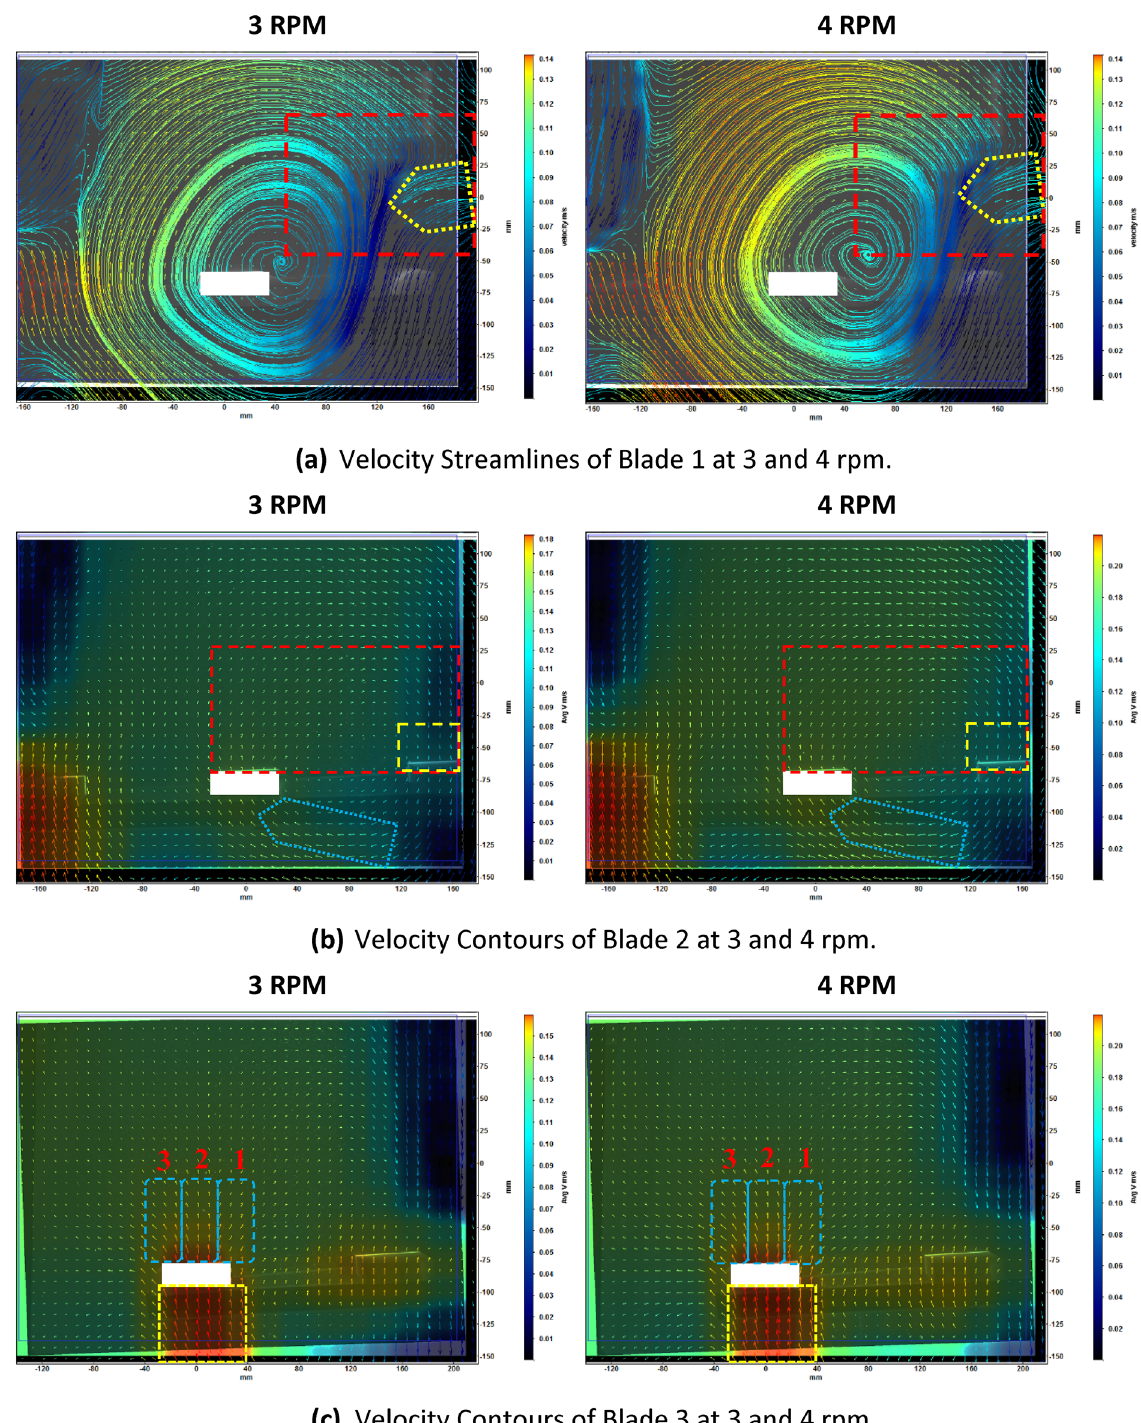
Figure 4. Velocity fields and streamlines of the three blades at the two rotating speeds of 3 and 4 rpm. Maximum average velocity at 3 rpm was 0.15 m/s, 0.20 m/s and 0.16 m/s respectively for the three blades, and the maximum average velocity at 4 rpm was 0.15 m/s, 0.22 m/s and 0.22 m/s respectively for the three